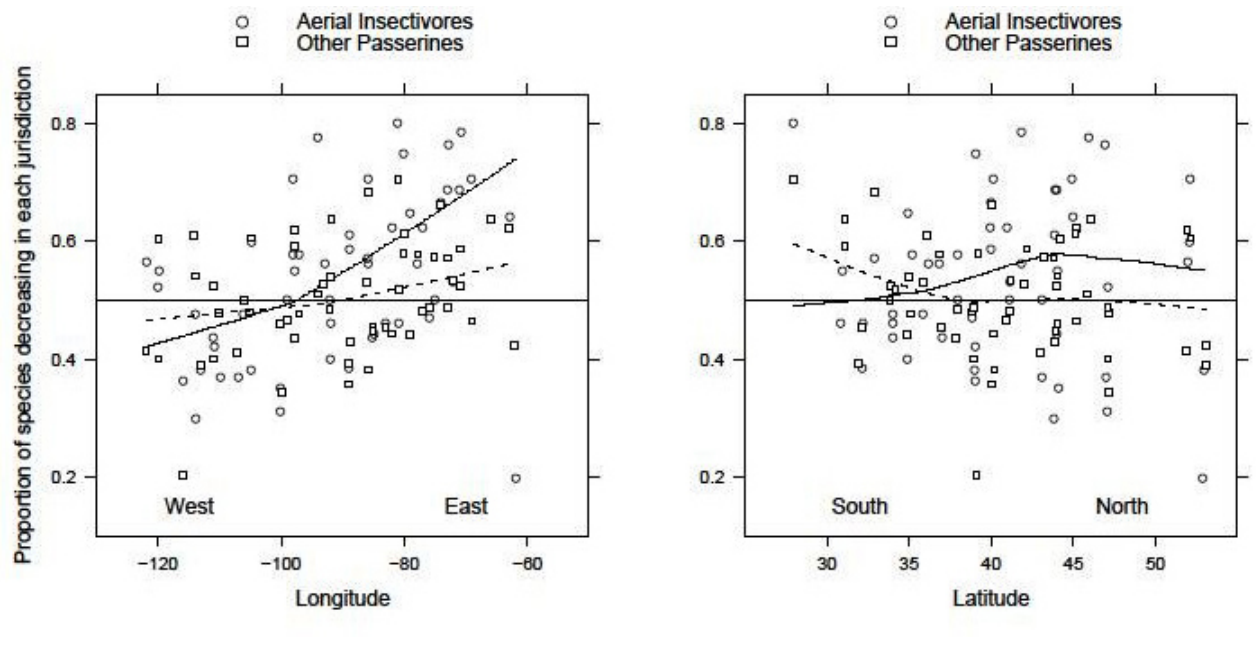
Fig. 1 . The proportion of species declining in each jurisdiction (states and provinces), and locally weighted regression lines for aerial insectivorous passerines (circles and solid lines) and for all other passerines (squares and stippled lines) in the lower 48 United States and in southern Canada. Aerial insectivores in the east and north of North America are disporpotionately more likely to be declining than other passerine species in these